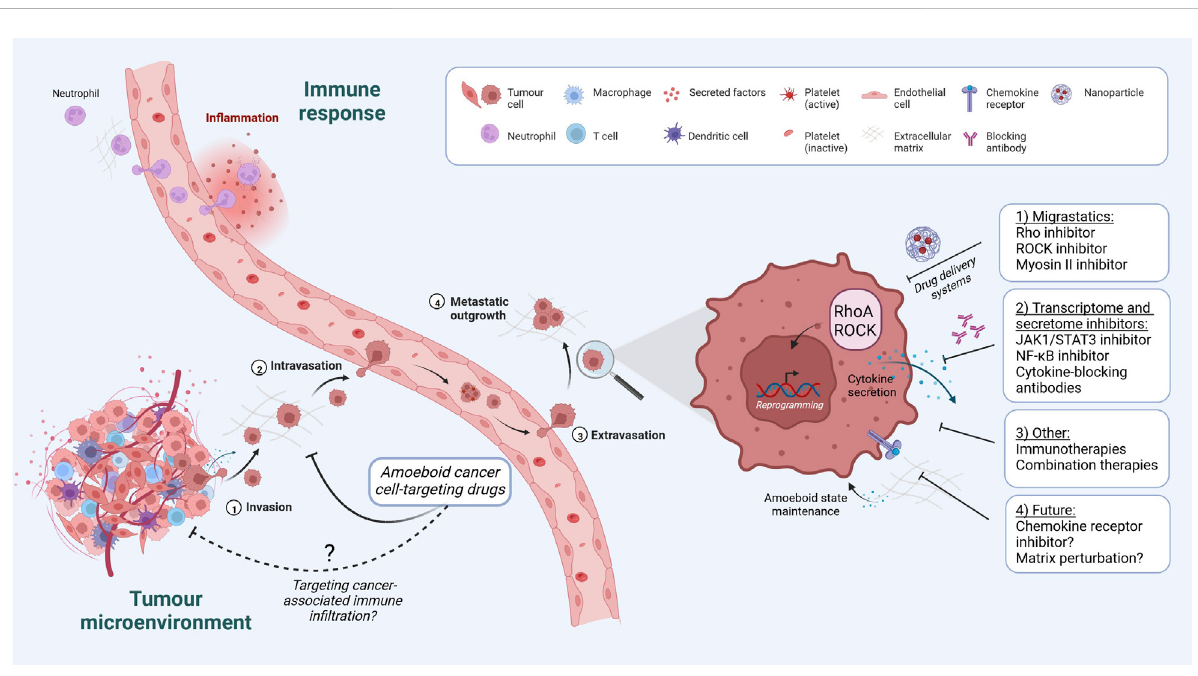
FIGURE 1 Targetingamoeboidcancercellsduringtumourprogression.Bothleukocytesandtumourcellsutiliseamoeboidmigrationfortheirmotility.We canaimtotargetdistincthallmarksofamoeboidcancercellswithinthetumourmicroenvironment,whilstleavinghomeostaticleukocytesintact.The effect of migrastatics on tumour-immune in fi ltrate is less understood, and should also be considered. Targeting approaches for amoeboid cancer cellsarehighlighted,frommigrastatics,transcriptomeandsecretomeinhibitors,immunotherapiesandcombinationtherapies,alongsidefuture considerations for therapies such as chemokine receptor